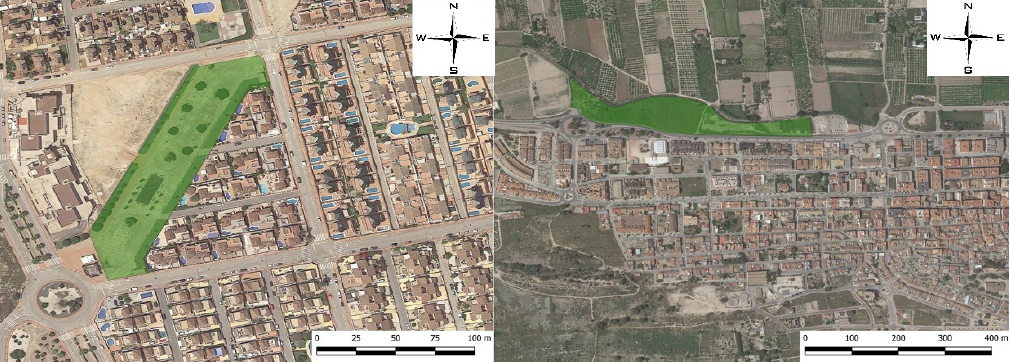
Figure 3. Examples of floodable parks analysed. Own elaboration based on [29] and Google Maps.